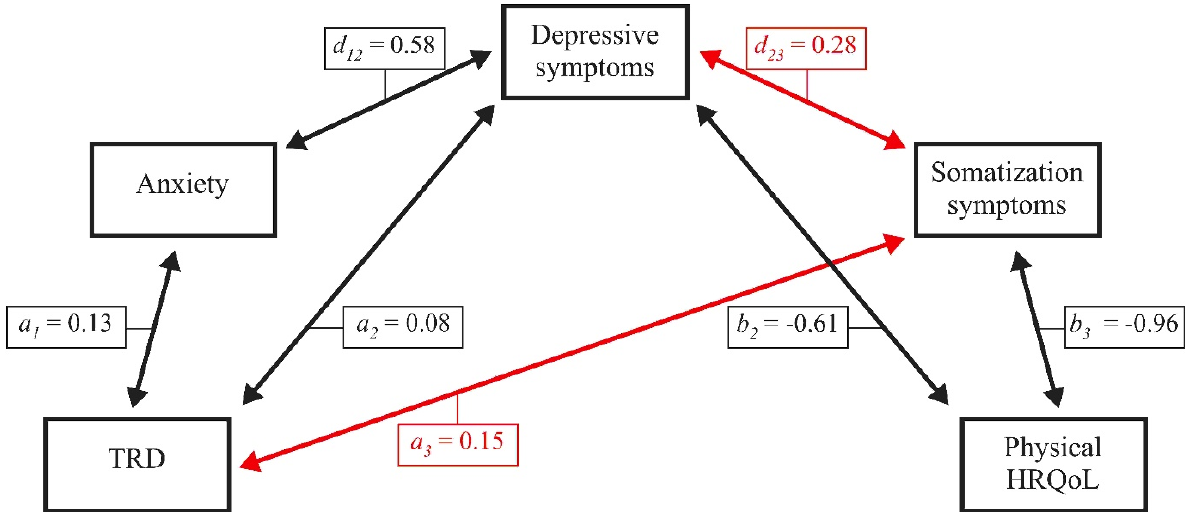
Figure 2. Anxiety, depressive symptoms, and somatization symptoms completely mediate the effect of TRD on physical HRQoL in female patients with chronic tinnitus. TRD = tinnitus-related distress; HRQoL = health-related quality of life. Numbers indicate unstandardized multiple regression coefficients. Red lines indicate effects that are significant in female patients only.